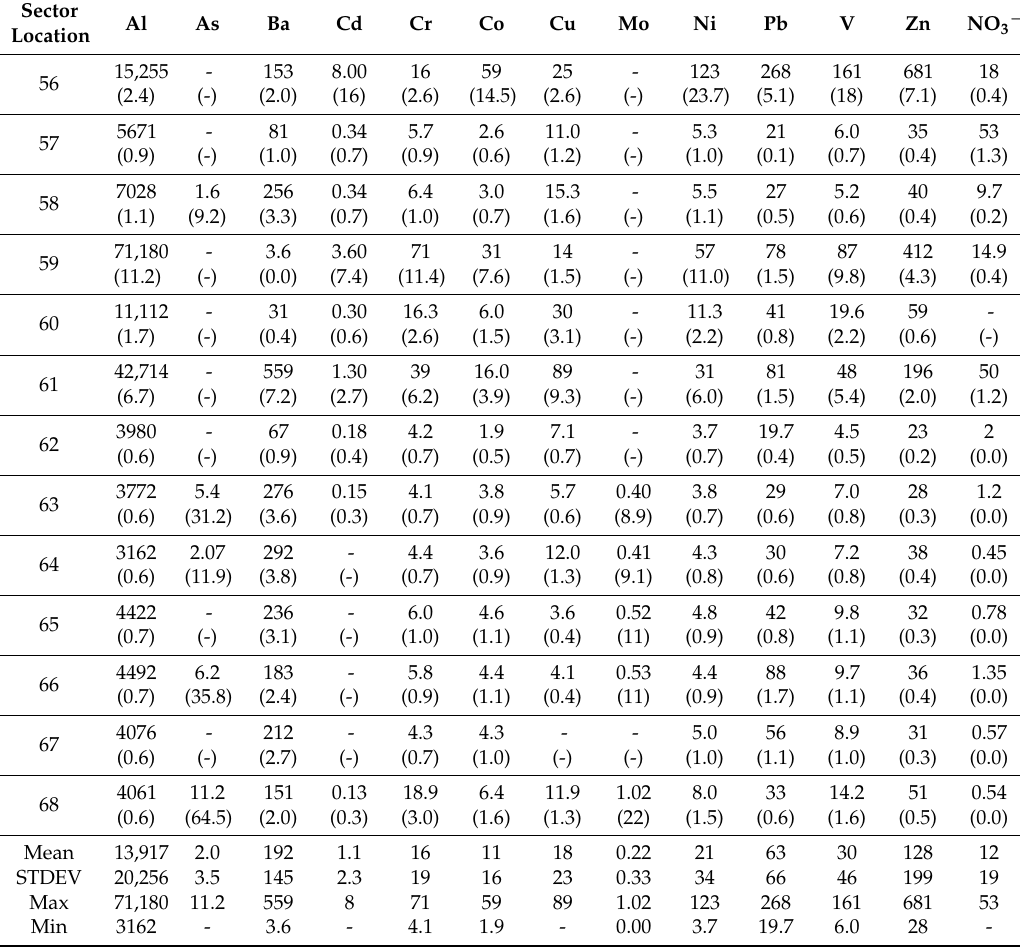
Table 3. Data for metals and NO 3 − concentrations in E sector.